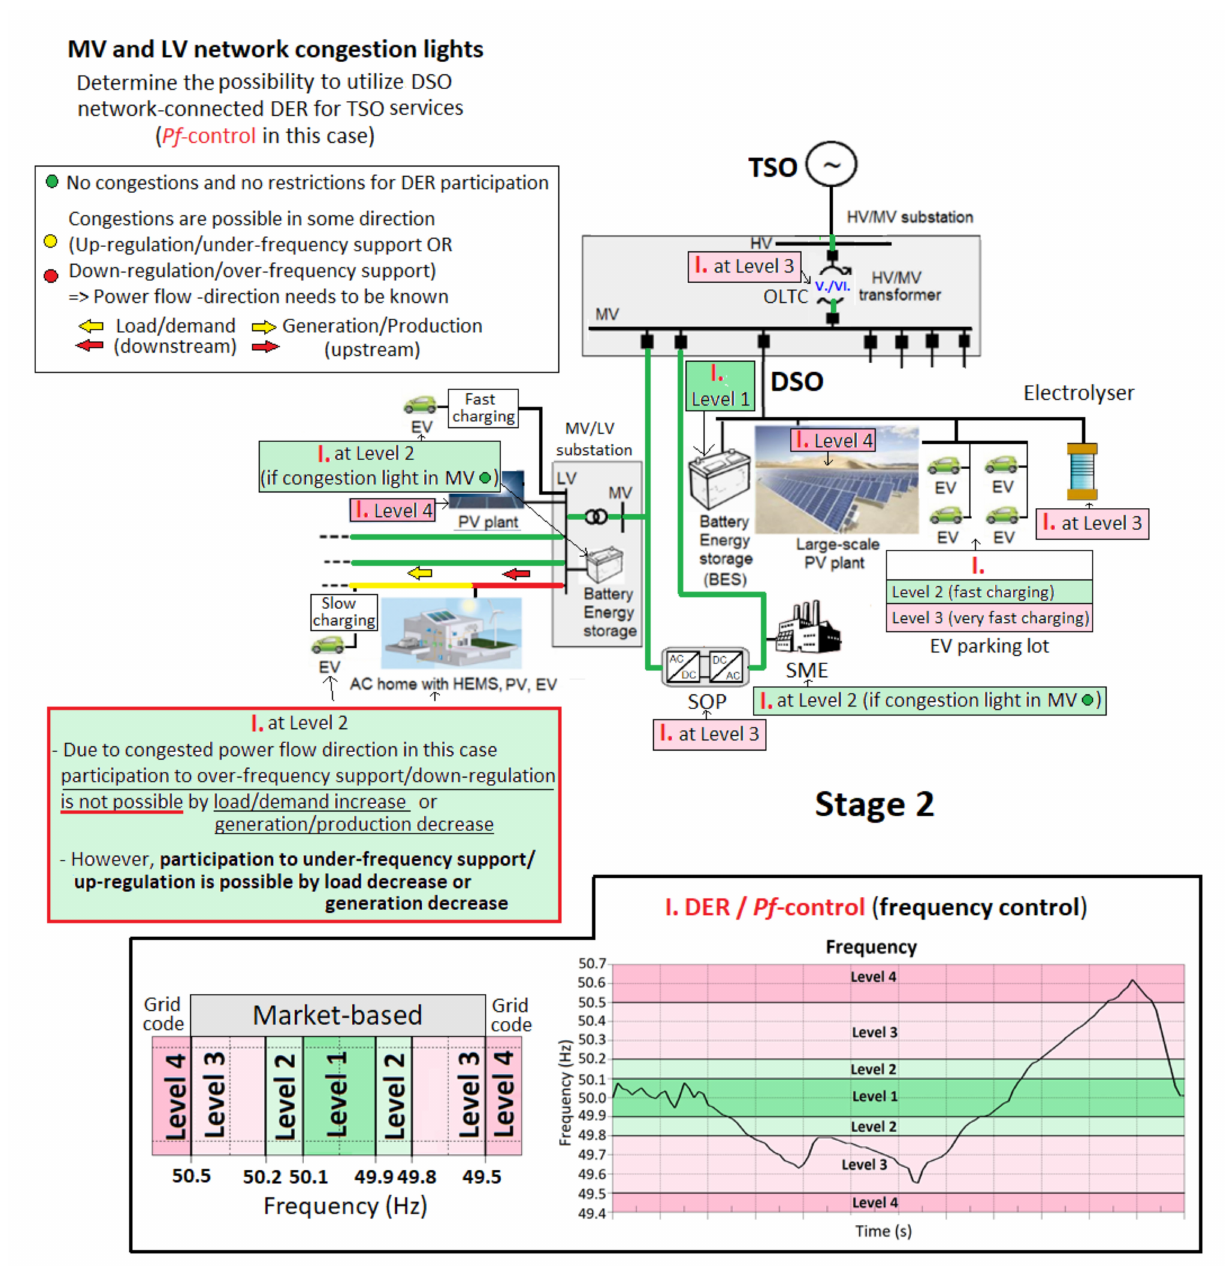
Figure 8. DSO network-connected DER participation on the provision of TSO frequency control services at evolution stage 2 through different markets also considering the location and type of DER as well as possible DSO network congestions (see Tables 1–5 and Figure